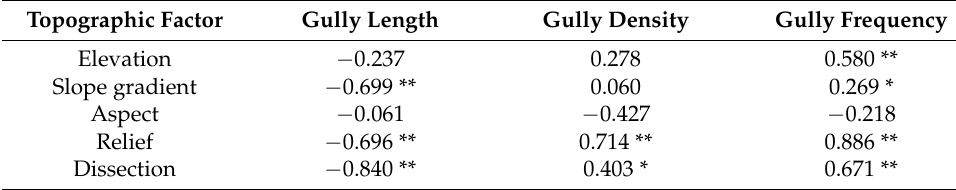
Table 3. Correlation test of topographic factors and gully parameters. Topographic Factor Gully Length Gully